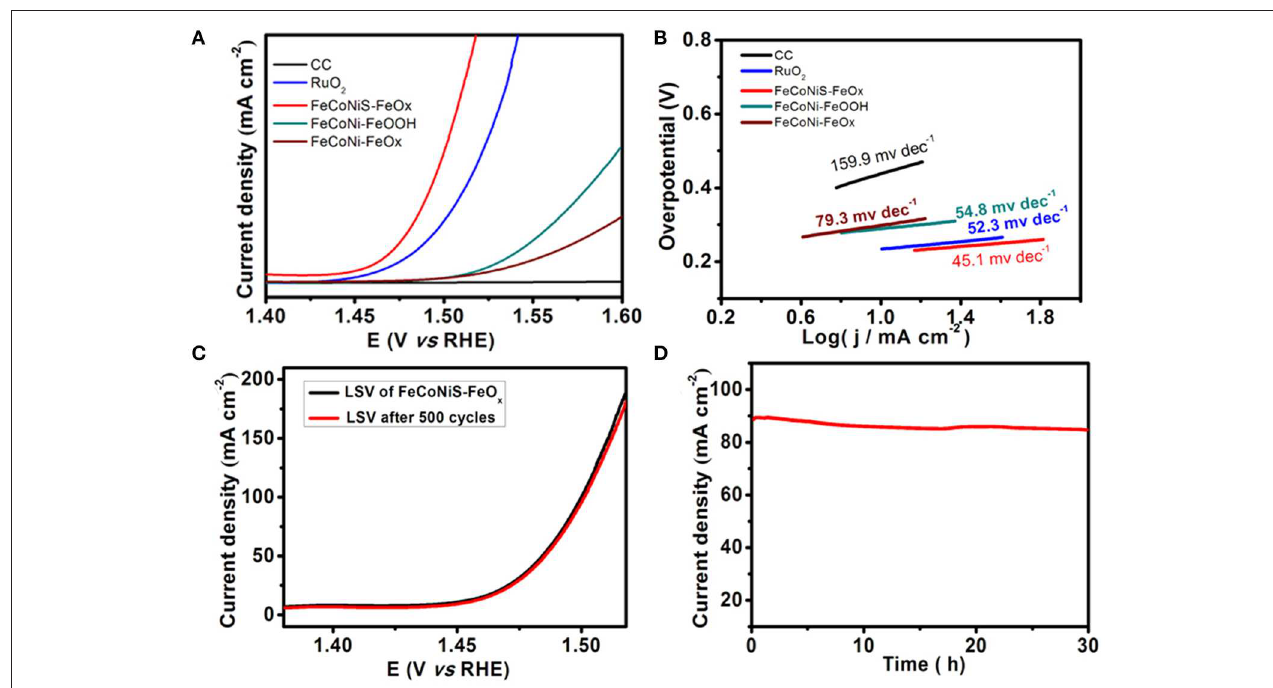
FIGURE 5 | (A) Linear sweep voltammetry (LSV) curves of different oxygen evolution reaction (OER) catalysts. (B) Tafel curves of different OER catalysts. (C) LSV curve of FeCoNiS-FeO x catalyst and another curve after 500 CV cycles. (D) Time-dependent current density curve of FeCoNiS-FeO x OER catalyst under constant potential.